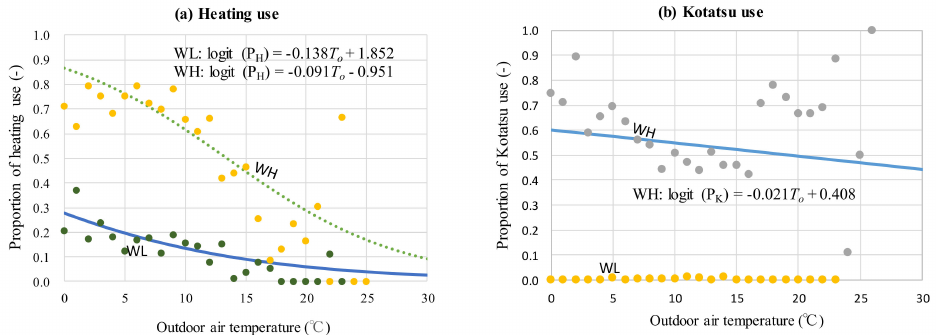
Figure 12. Relationship between heating use and outdoor air temperature for higher and lower temperature groups: ( a ) Heating use and ( b ) Kotatsu